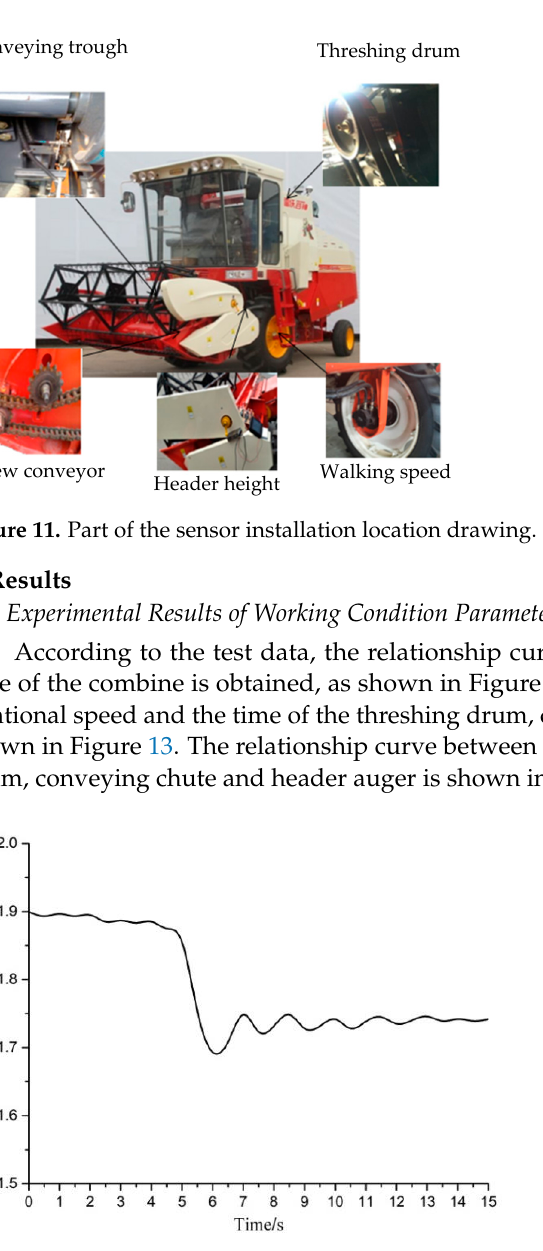
( c ) Figure 13. The relationship curve of rotation speed and time of the threshing drum, conveying trough and cutting table screw conveyer. ( a ) Speed of auger, ( b ) speed of conveyor, ( c ) speed of threshing drum.